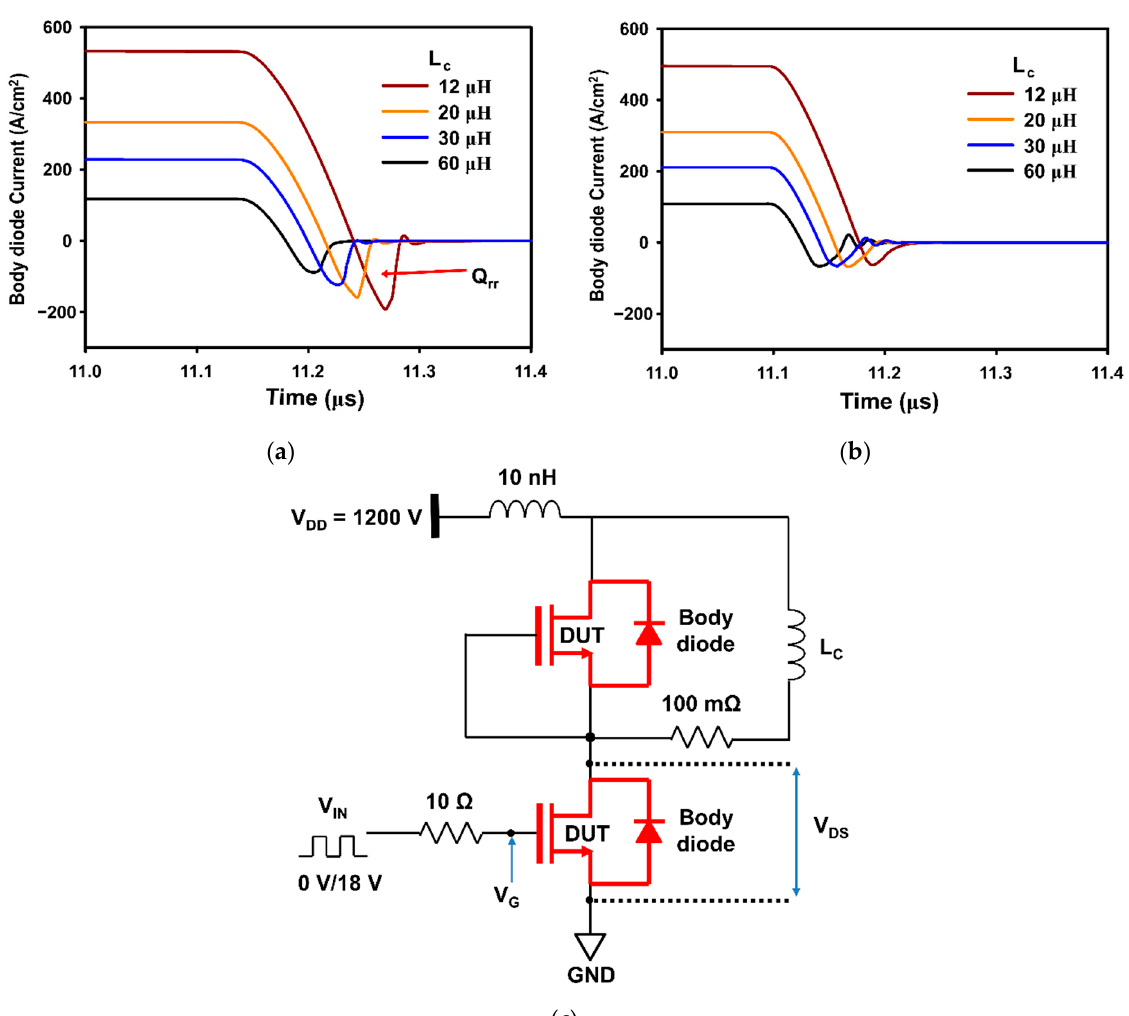
Figure 10. Comparison of the reverse recovery characteristics with different L C of ( a ) DT-MOSFET ( b ) DTMCD-MOSFET ( c ) Circuit diagram of double pulsed test for switching. Table 2. Reverse recovery charge according to L C value.